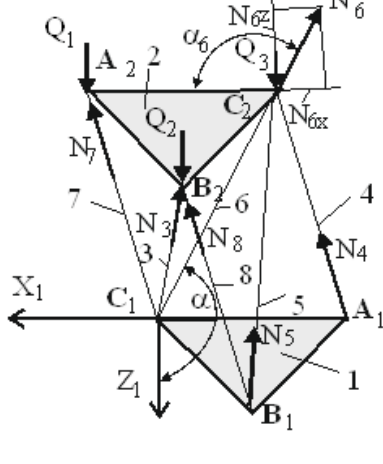
Figure 5 . Design